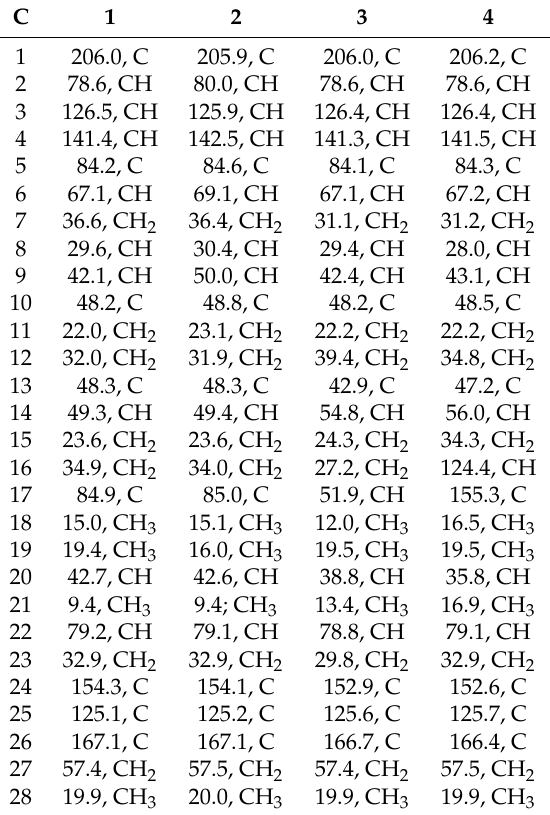
Table 2. 13 C-NMR spectroscopic data for compounds 1 – 4 a